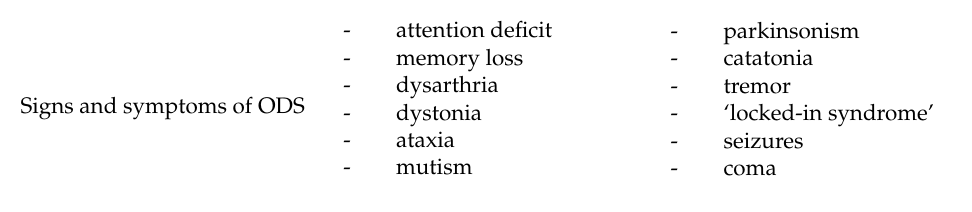
Table 1. Signs and symptoms of osmotic demyelination